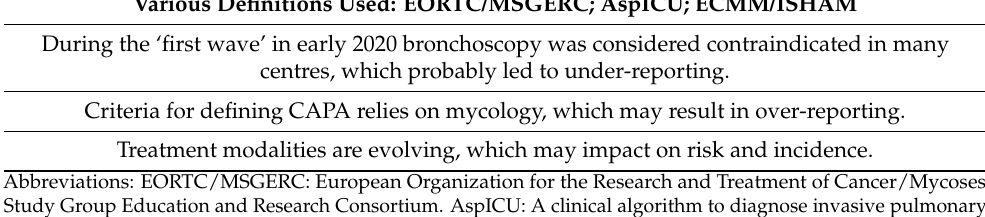
Table 1. Potential reason of the heterogeneity of the reported incidence of patients with COVID-19- associated pulmonary aspergillosis